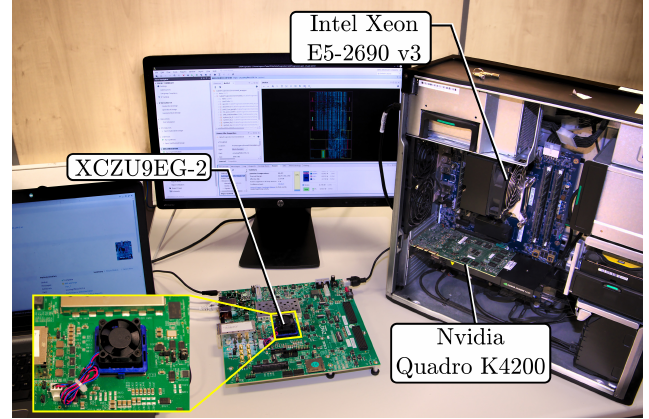
Figure 17. Setup used for the FPGA and software